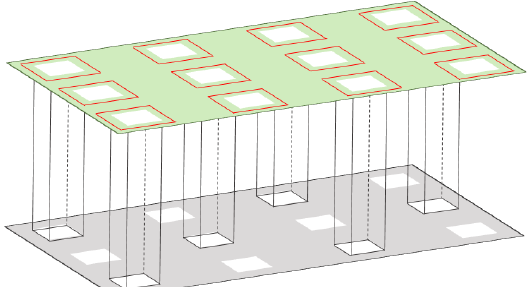
Figure 3. Gaps in the floor (grey plane) and the ceiling (green plane).